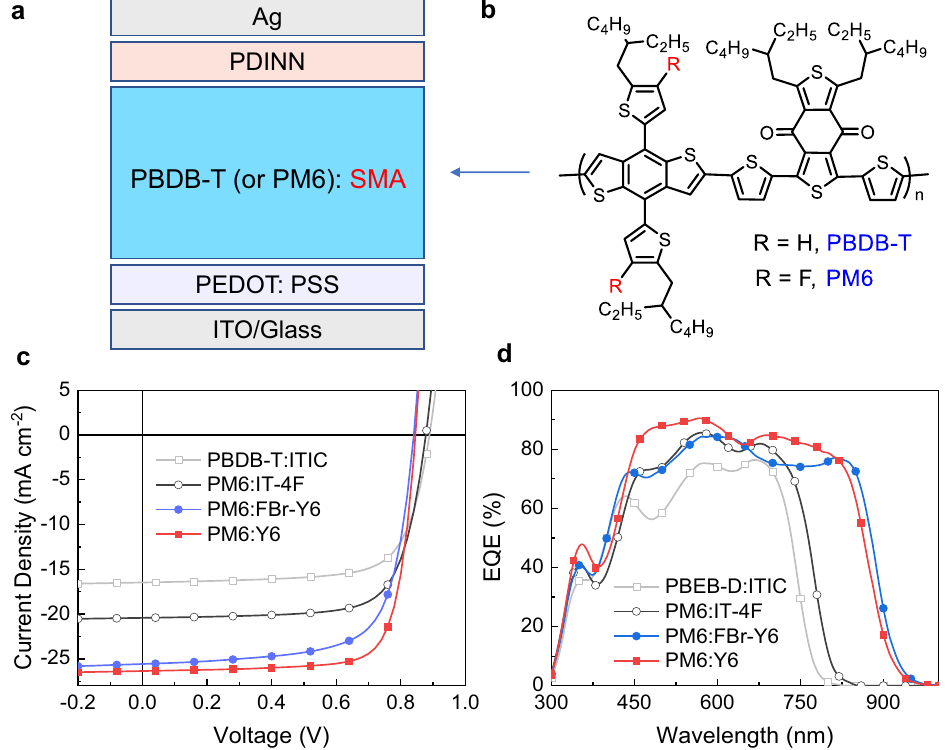
Fig. 4 Photovoltaic performance of the PSCs. a Device structure of the PSCs. b Chemical structure of polymer donors; c J – V curves of the best PSCs based on PM6: SMAs (ITIC, IT-4F, FBr-Y6 and Y6, synthesized by BF 3 ∙ OEt 2 -catalyzed Knoevenagel condensation) blend under the illumination of AM 1.5 G, 100 mWcm − 2 . d EQE spectra of the best